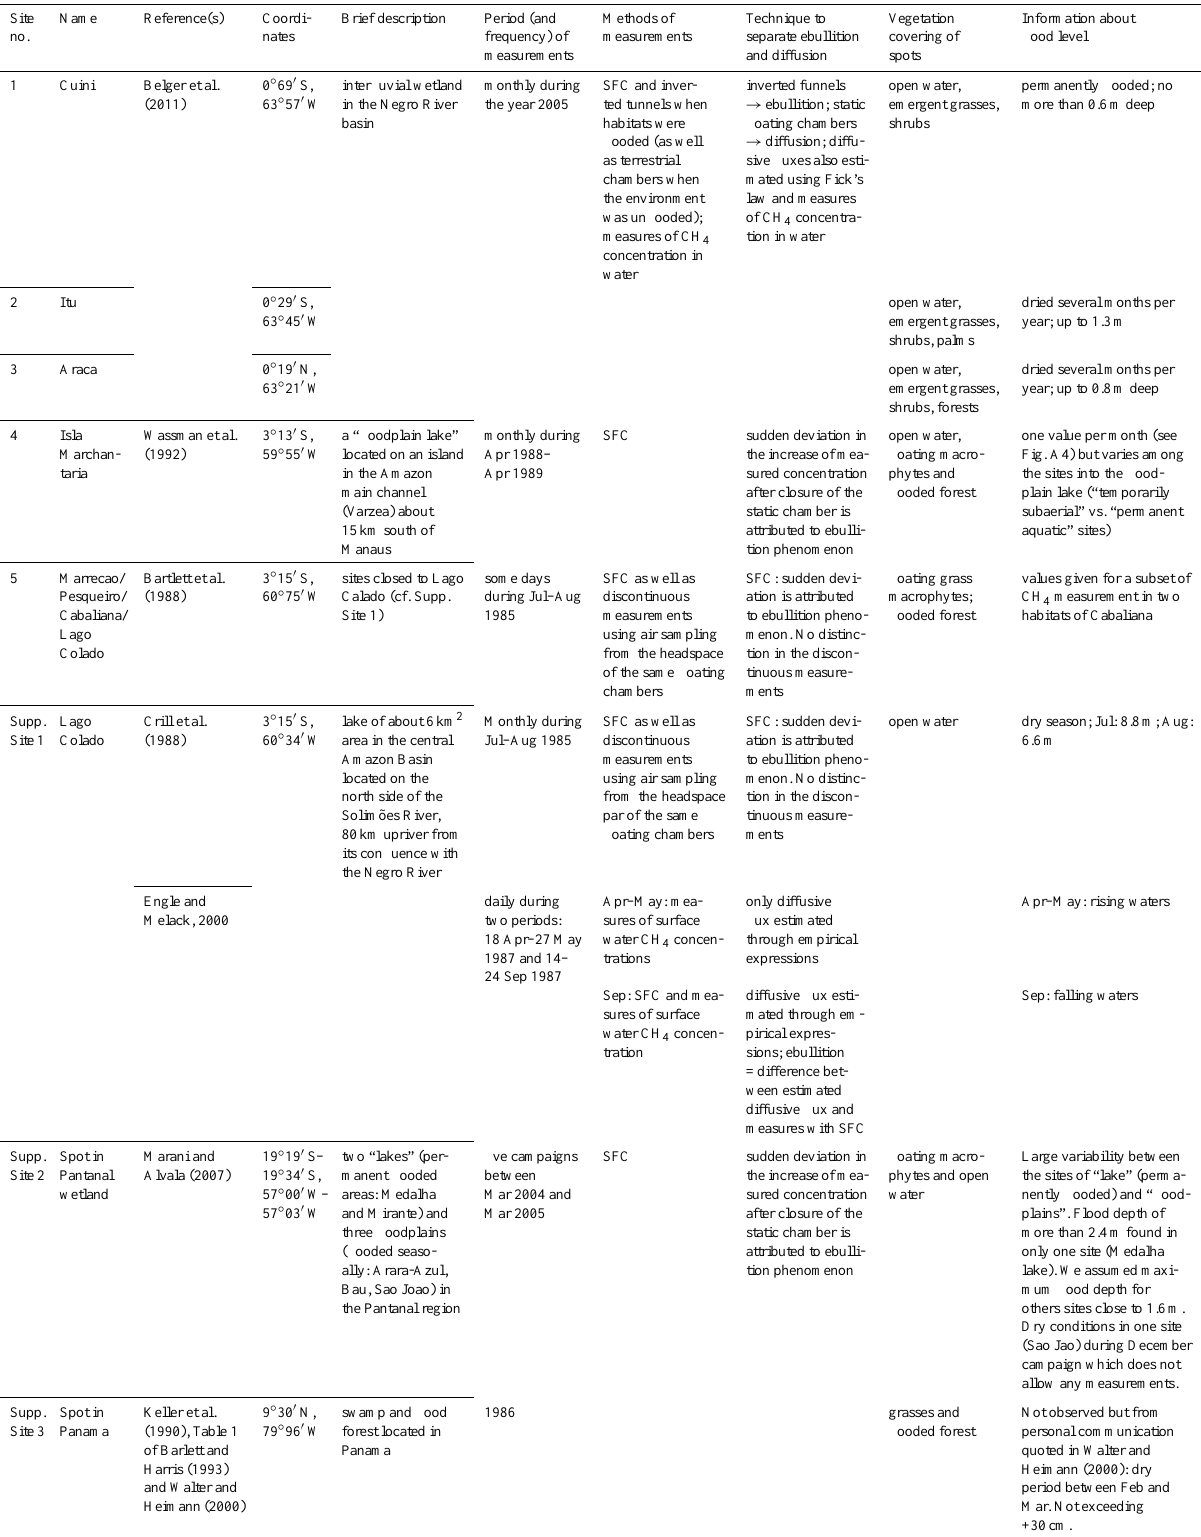
Table 2. Description of sites used for sensitivity analysis and CH 4 flux density evaluation. The three Supp. Sites will be used to discuss the ability of the here-developed LPX version to simulate open-water emissions and floodplain emissions outside of the Amazon Basin. Blank cells mean that no information is available and SFC refers to “static floating chamber”. Site